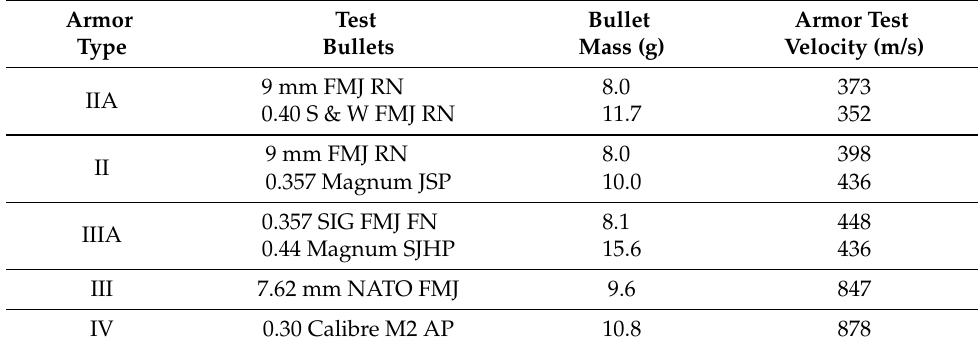
Table 3. Test requirements from NIJ 0101.06 standard [218].